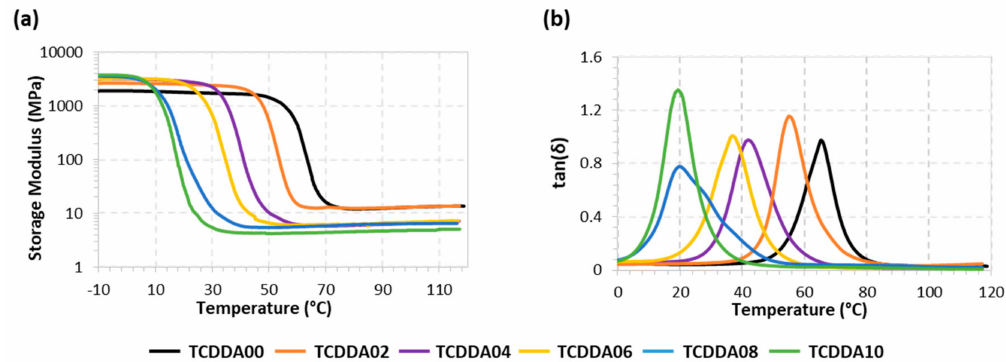
Figure 4. Storage Modulus ( a ) and tan δ ( b ) versus temperature during dynamic mechanical